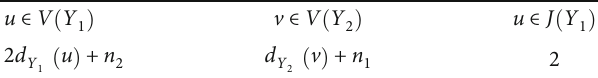
Figure 3: The VRG and ERG of P ⊕ Y . Table 4: The degree distribution of Y R 1 2